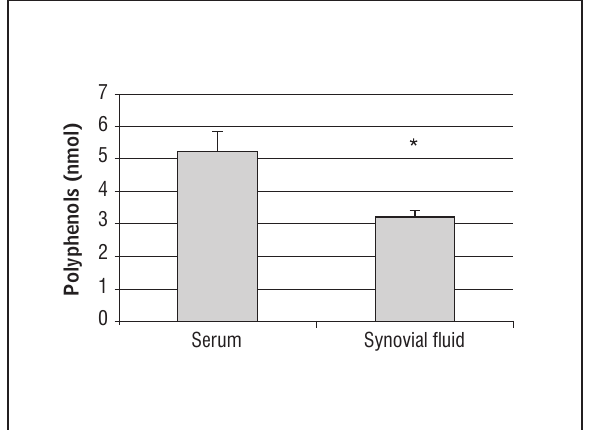
Figure 1 - Comparative analysis of polyphenol concentration in serum and in SF